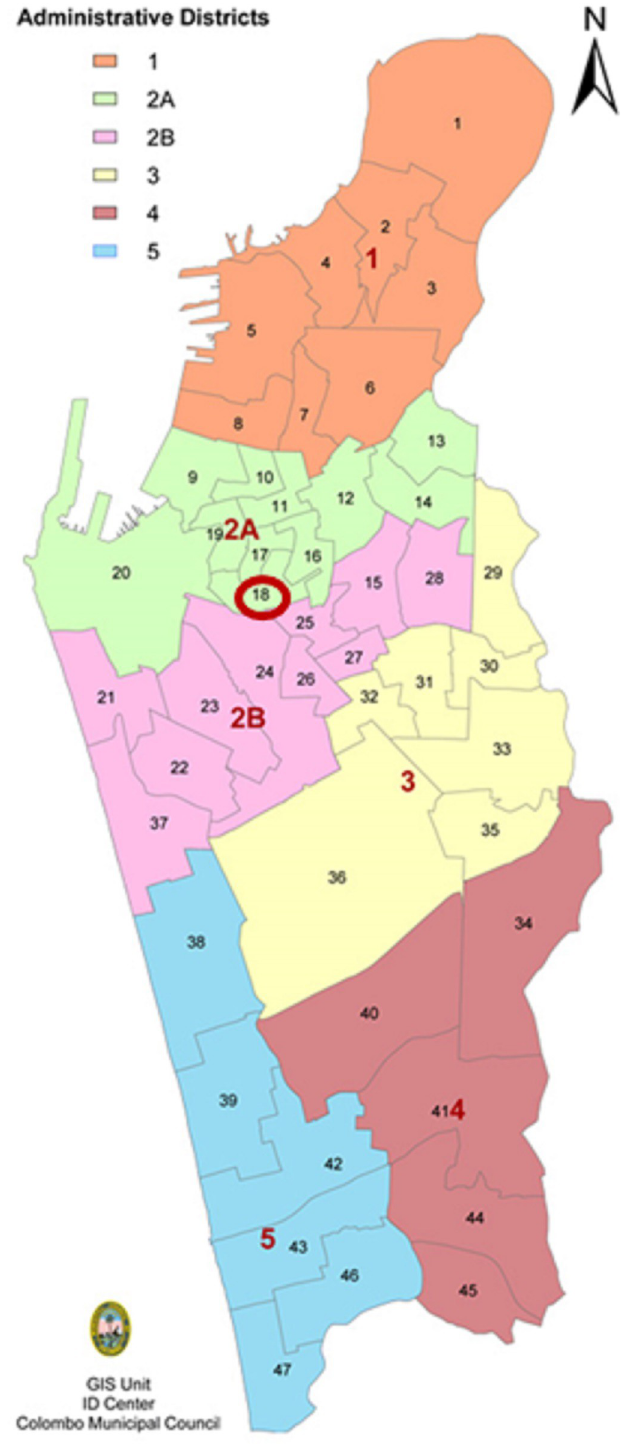
Fig 1. A map of the District 2A areas of the Colombo municipality council. The location of the Bandaranayaka watta is circled in red. The figure is from GIS unit ID Center, Colombo Municipal Council Sri Lanka.